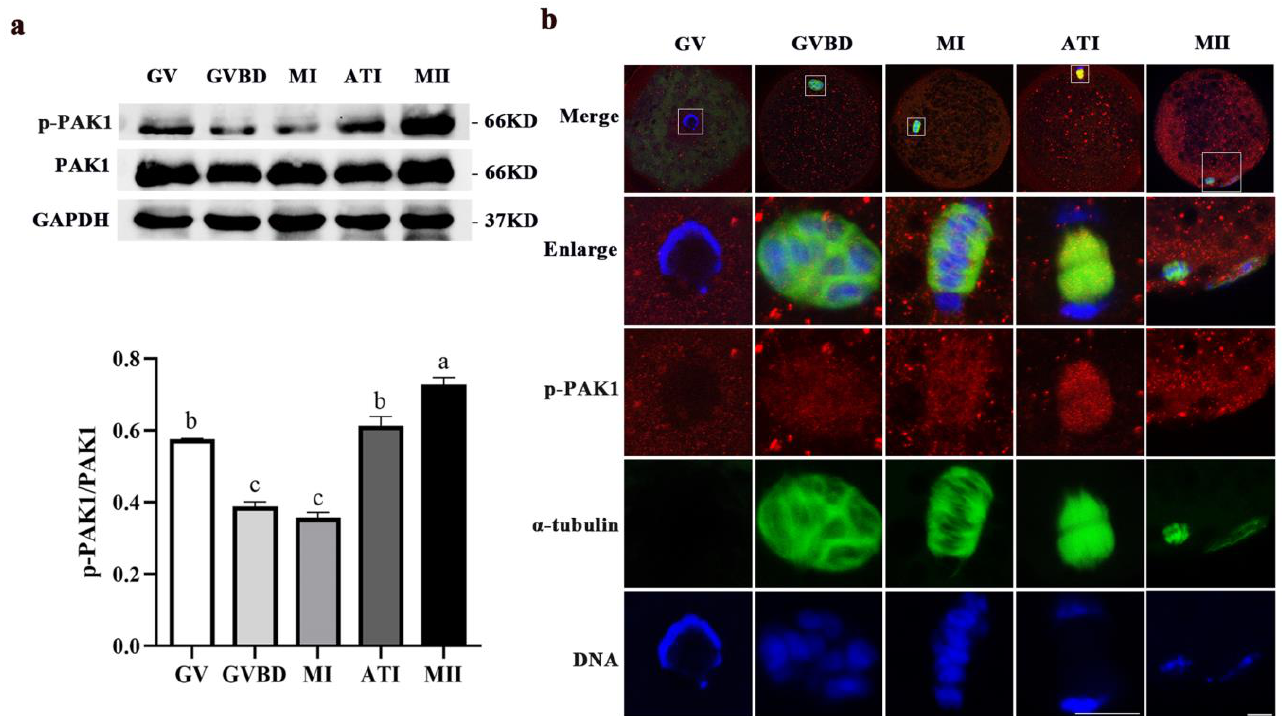
Figure 1. Localization and relative expression of PAK1 meiotic maturation in porcine oocytes. ( a ) The relative expression of p-PAK1 and total PAK1 in porcine oocytes undergoing meiosis. a, b, c Values with different superscript letters above columns indicate significant differences ( p < 0.05). ( b ) Subcellular localization of p-PAK1 during meiosis in porcine oocytes ( n = 40). Red, p-PAK1. Green, α-tubulin. Blue, chromosome. Scale bars are 10 μm. GV, germinal vesicle; GVBD, germinal vesicle breakdown; MI, metaphase I; ATI, anaphase-telophase I; MII, metaphase II.